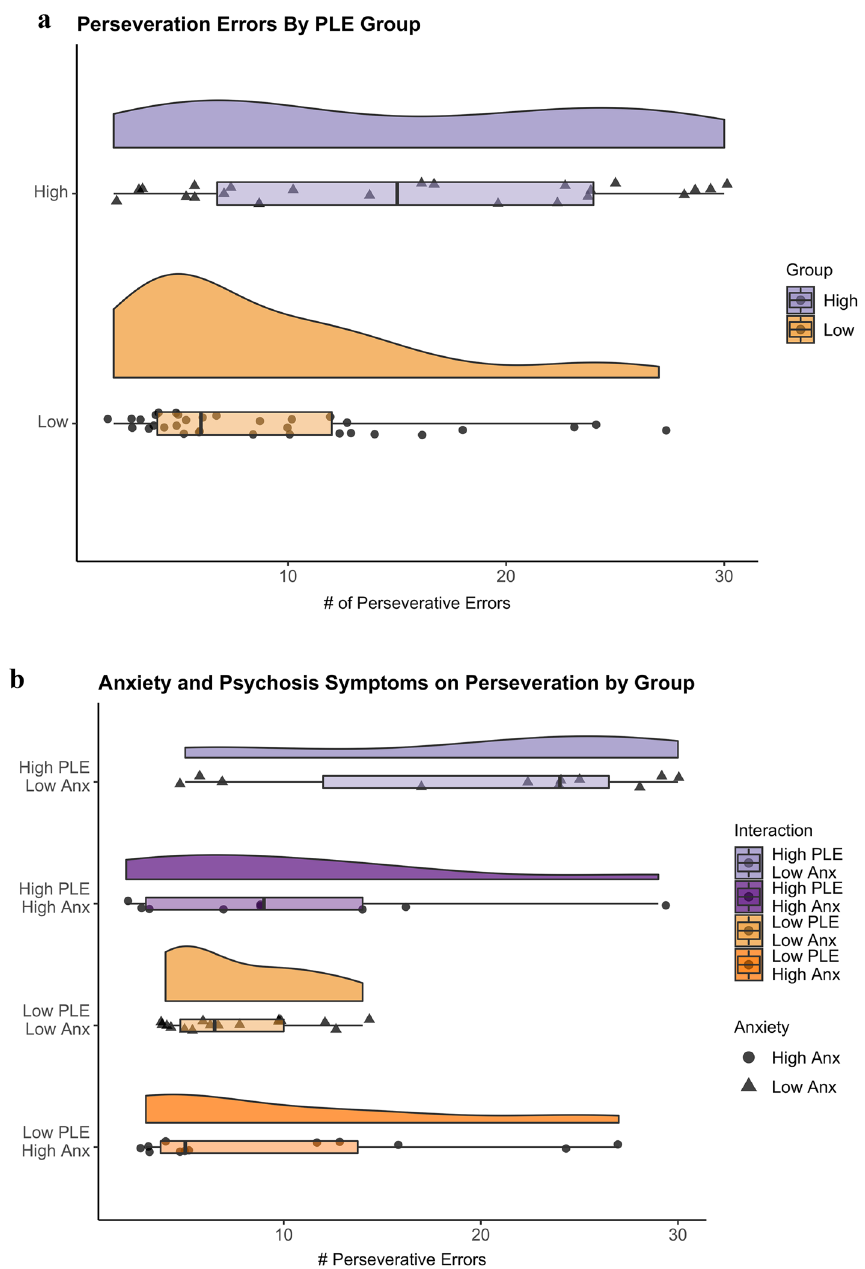
Figure 4. ( a ) Perseverative Errors by PLE group. The high-PLE group made significantly more perseverative errors compared to the low-PLE group. PLE psychotic-like experiences. ( b ) Perseverative errors relate to anxiety symptoms in the high-PLE group. Individuals with greater levels of anxiety in the high-PLE group made perseverative responses comparable to those with low-PLE. Note that the PLE groups were divided into different high/low anxiety groups for illustrative purposes only and all analyses treated anxiety symptoms continuously. Anx anxiety symptoms, PLE psychotic-like